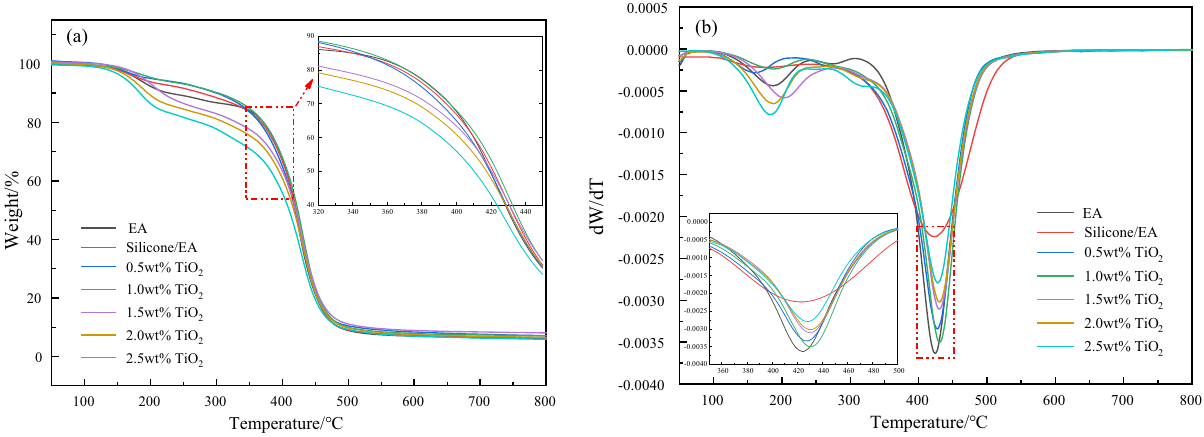
Figure 13: Thermogravimetric curve of TiO 2 - modi fi ed resin: ( a ) TG and ( b ) DTG.